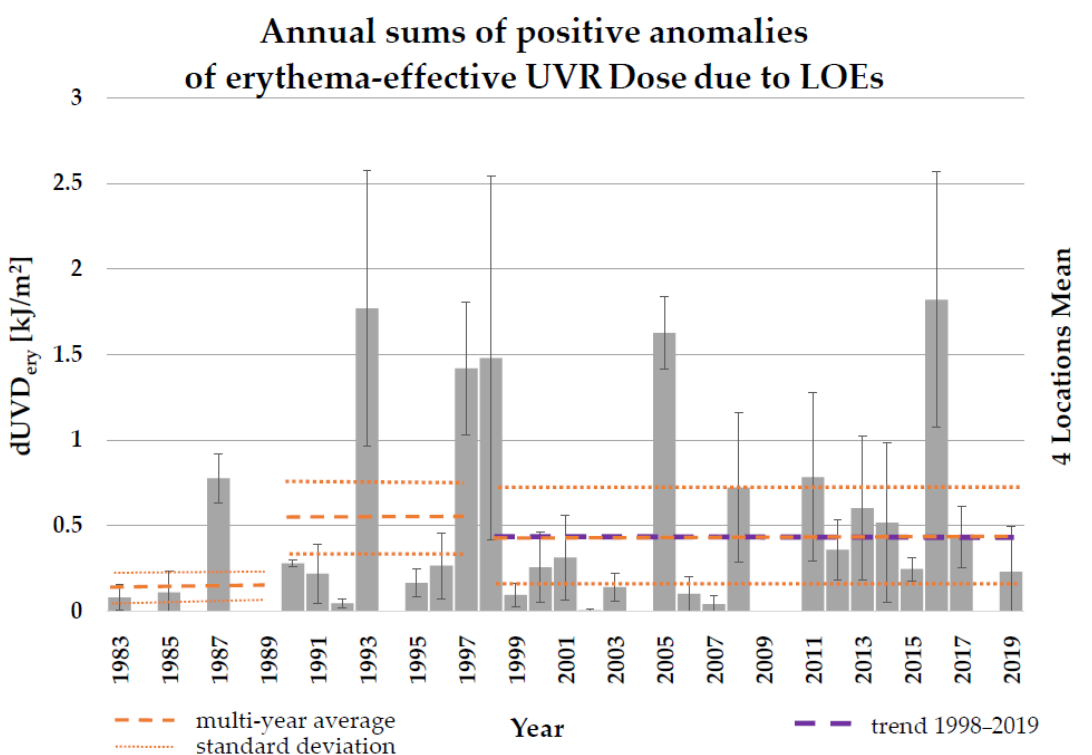
Figure 9. Mean annual sums of the anomalies of the erythema-effective UVR dose associated with LOEs together with the linear trend of the subperiod 1998–2019 (purple dashed line) and the averages of the subperiods T1 (1983–1989), T2 (1990–1997), T3 (1998–2019) (orange dashed lines), (4-location means and standard deviations).